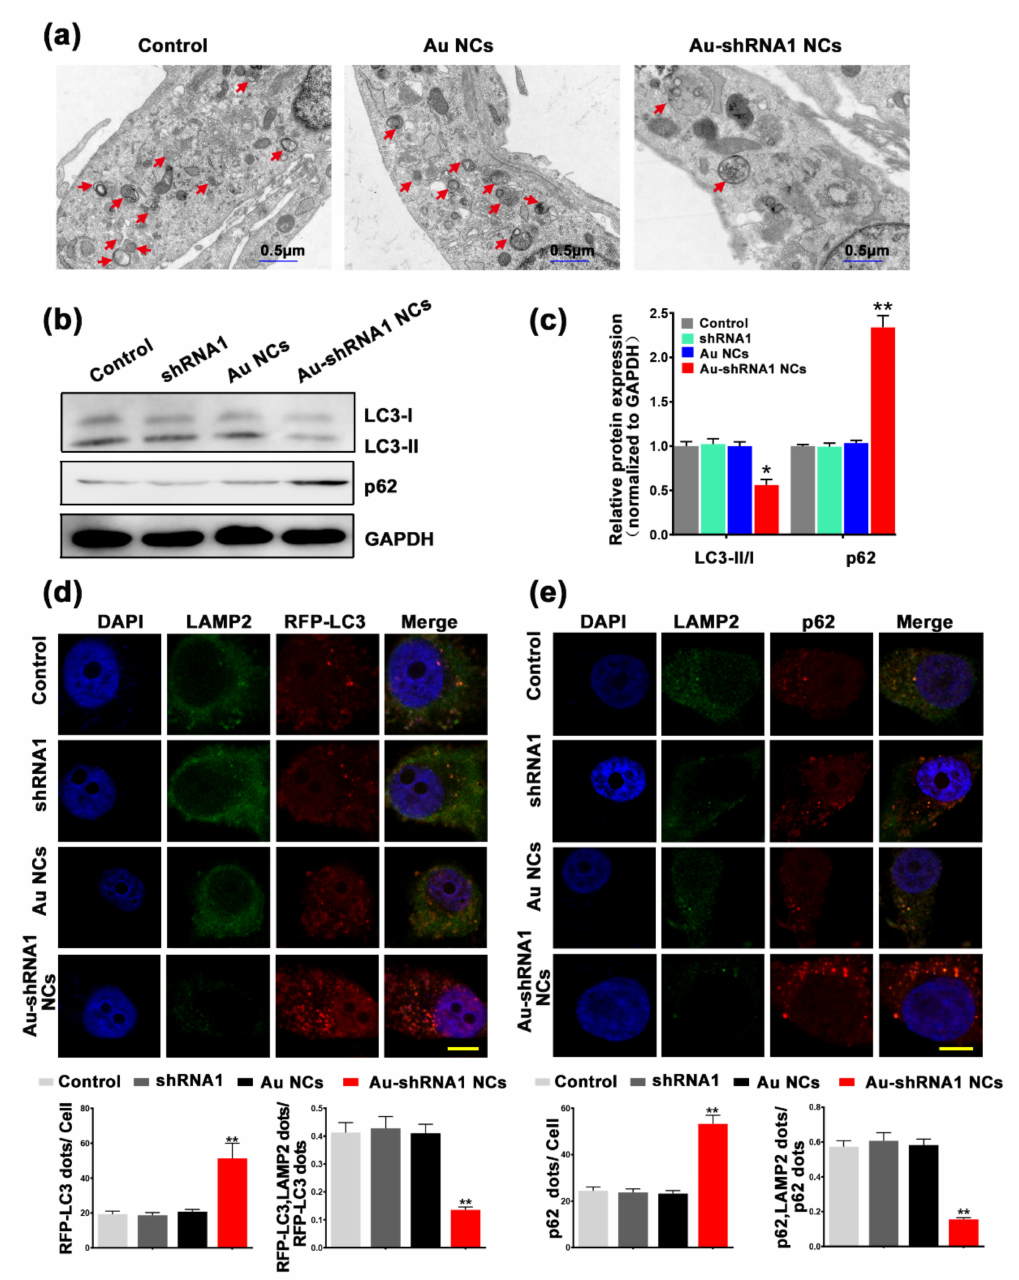
Figure 5. Silencing of MALAT1 by Au–shRNA1 NCs inhibits autophagic flux. ( a ) Bio-TEM images of HepG2 cells showing the accumulation of autophagosomes with or without gold salt treatment (bars = 0.5 µ m). Red arrows indicate autophagosomes. ( b , c ) Western blot analysis was used to compare the expression levels of LC3 and p62 in the untreated control group, shRNA1, Au NC, and Au–shRNA1 NC groups. * p < 0.05, ** p < 0.01 ( n = 3–5). ( d ) Representative images show RFP-LC3 and LAMP2 expression among different groups of HepG2 cells. Cells were first transfected with RFP-LC3 for 24 h, and then separately incubated with the shRNA1, gold salt, or the shRNA1 and gold salt together for 12 h. DAPI staining was applied to observe the cell nucleus. Scale bar: 5 µ m. The figure shows the quantification of RFP-LC3 (red) dots. The bottom graph shows the combined point/RFP-LC3 ratio. ** p < 0.01 ( n = 3–5). ( e ) Representative images of p62 and LAMP2 between different groups. The yellow dots in the merged image indicate the co-localization of LAMP2 and p62. Scale bar: 5 µ m. The quantitative analysis of p62 (red) spots/cells and fusion spots/p62 in HepG2 cells is indicated (bottom). ** p < 0.01 ( n =